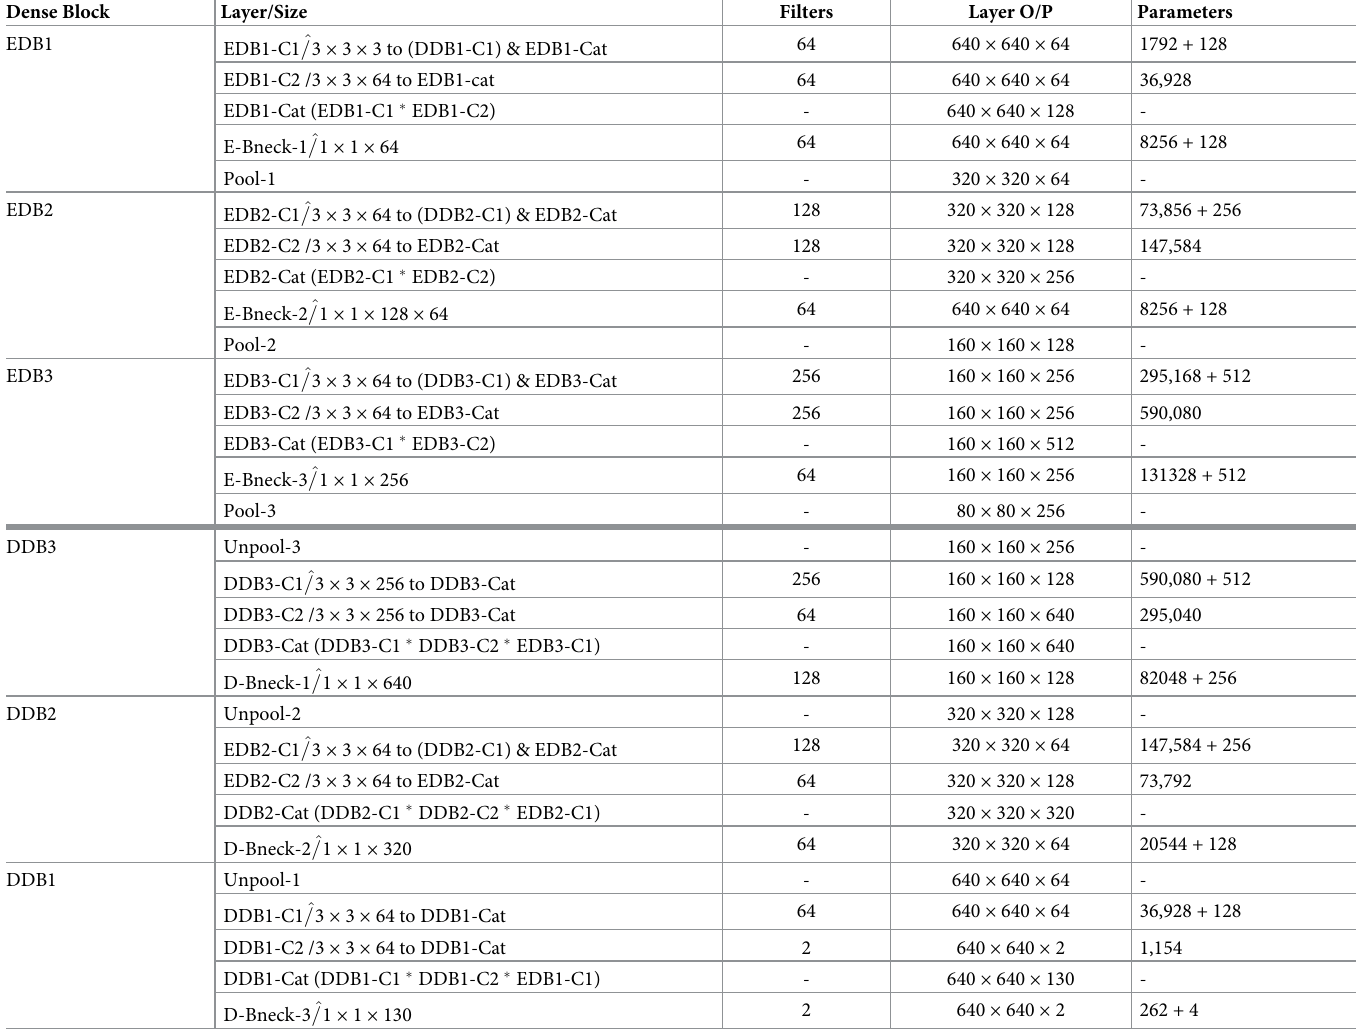
Table 2. DAVS-Net encoder-decoder I/O feature map sizes. Where EDB, EDB-C, EDB-Cat, DDB, DDB-C, DDB-Cat represent encoder dense block, encoder dense block convolution, encoder dense block concatenation, decoder dense block, decoder dense block convolution, decoder dense block concatenation, respectively. The layer with ^ = shows that layer includes rectified linear unit (ReLU), and batch normalization (BN) after. Dense Block